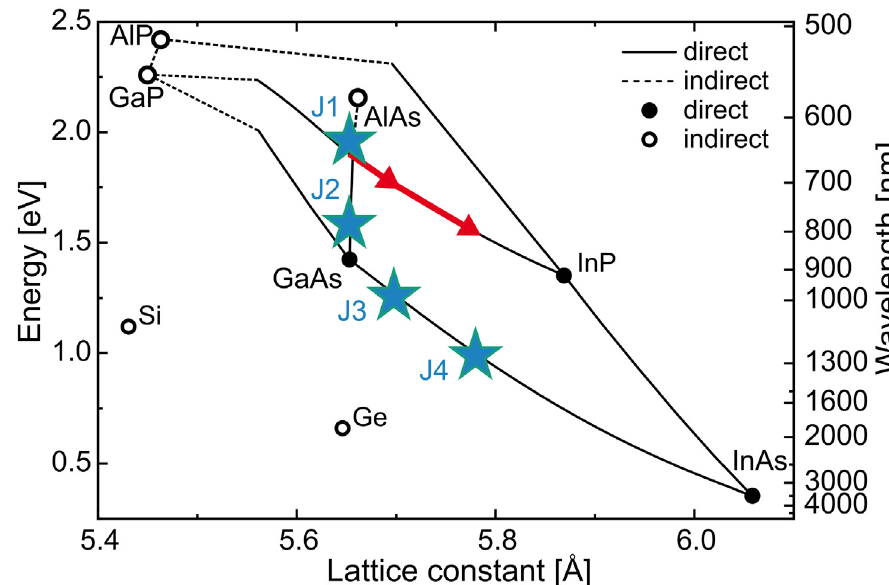
Fig. 2. Lattice constant vs. bandgap energy plot of III-V semiconductors. The four different absorber materials used in the IMM4J are marked as blue stars and the two GaInP step-graded metamorphic buffers are marked as red arrows. J1 is the Al 0.05 Ga 0.46 In 0.49 P, J2 is the Al 0.14 Ga 0.86 As, J3 is the Ga 0.89 In 0.11 As and J4 is the Ga 0.73 In 0.27 As